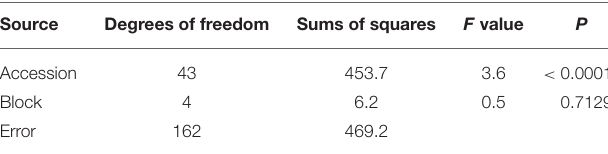
TABLE 4 | Analysis of allyl accumulation in foliar tissues of Arabidopsis